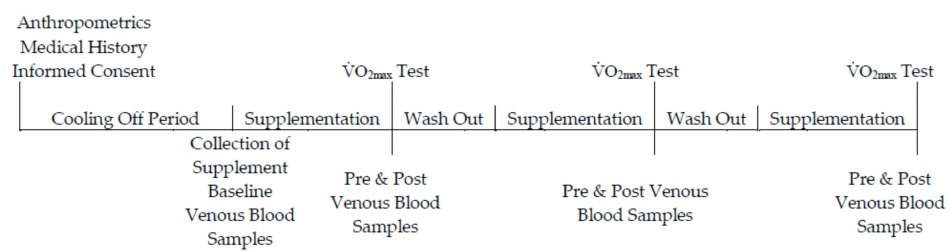
Figure 1. Schematic overview of the experimental protocol. Participants were allocated to one of the supplemental groups for 7 days. Following a 7-day washout period, participants crossed to another supplemental phase; this was repeated so each participant experienced each supplemented